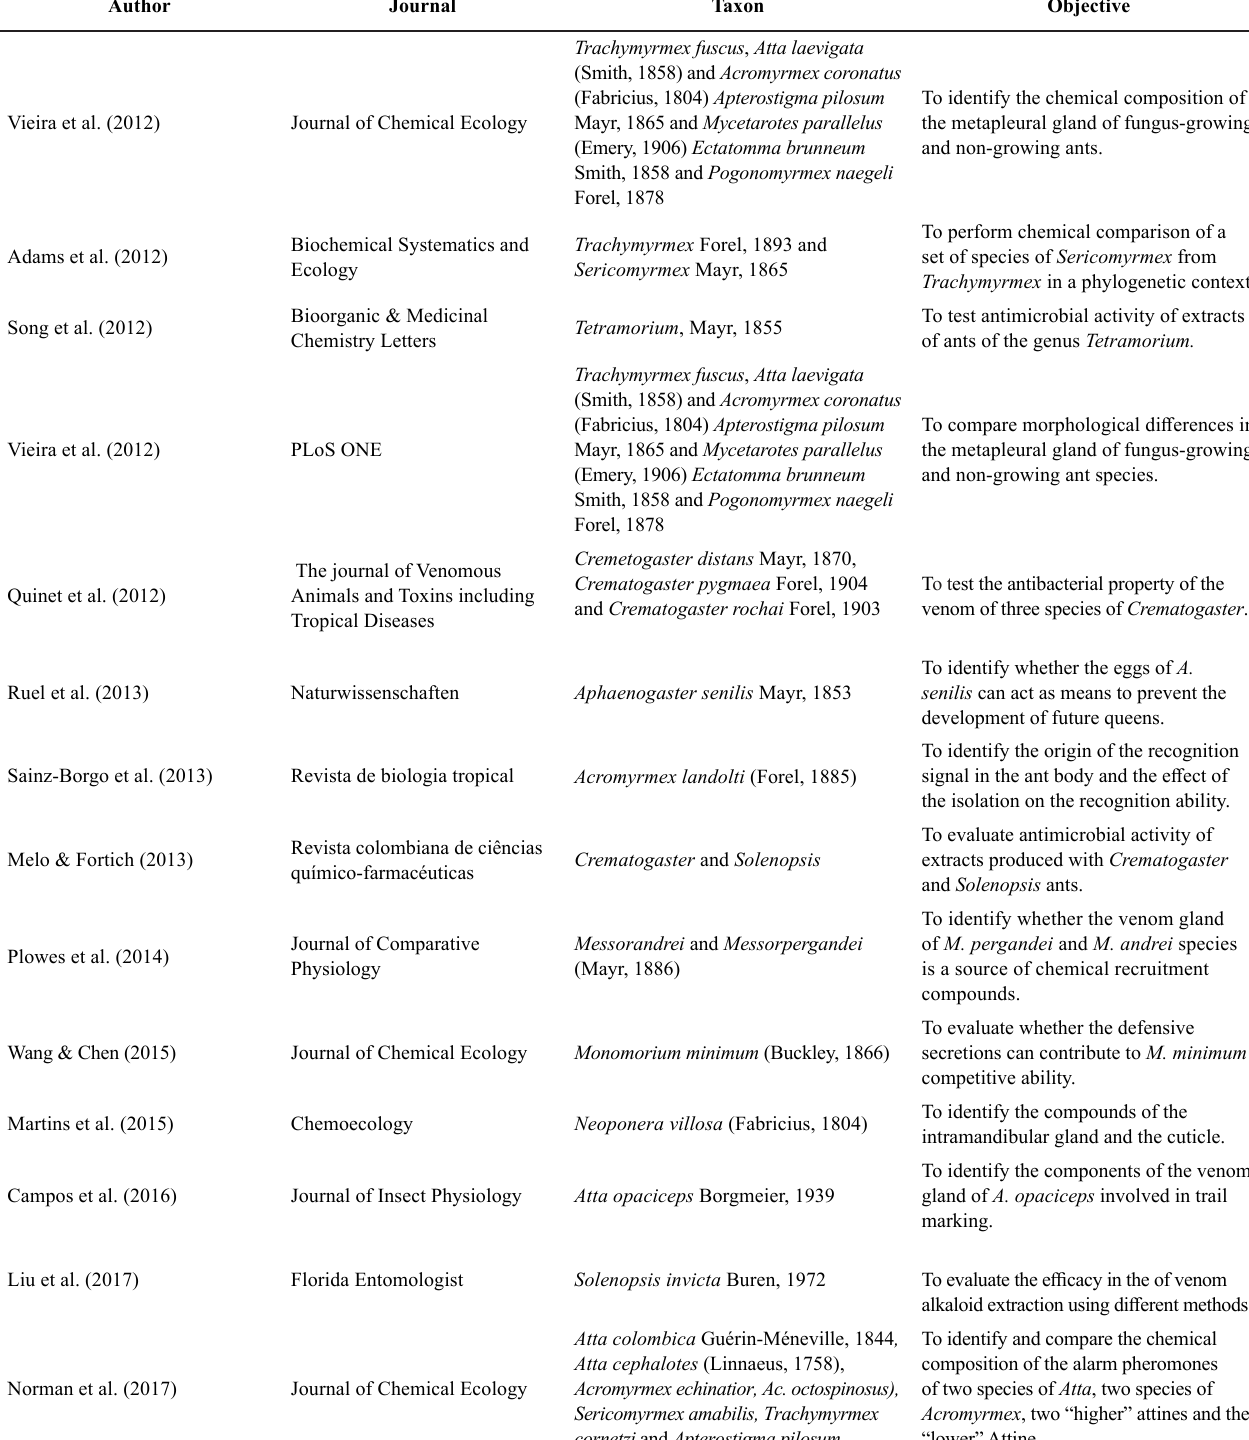
Table 1 . Authors, publication period, ant taxon used and objective of articles involving extraction of ant secretions in the period between 1989 and 2017.